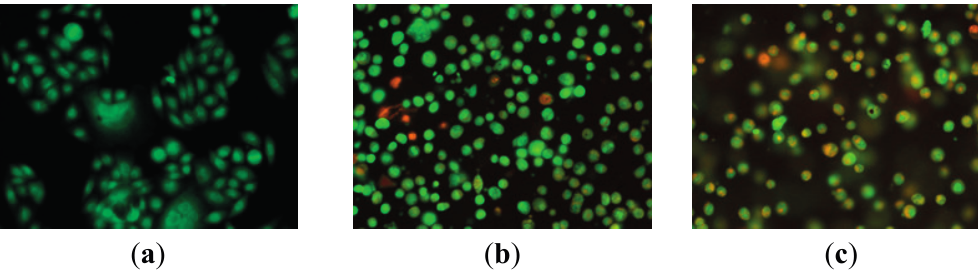
Figure 1. AO/EB staining of compound 9n in HeLa cells. ( a ) Not treated with the 9n were used as control at for 24 h and ( b , c ) treatment with compound 9n (10 μ M) for 12 and 24 h,